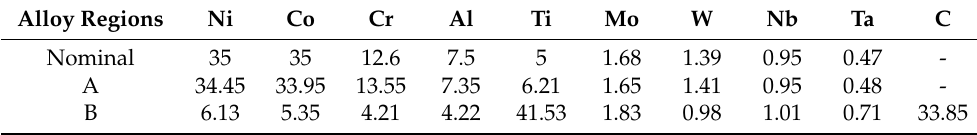
Figure 13. Microstructures for the HEA blocks at different sintering temperatures: ( a ) 950 °C; ( b ) 1000 °C; ( c ) 1050 °C; ( d ) 1100 °C; and ( e ) 1150 °C. Table 6. EDS analysis of the HEA blocks at different regions (at. %).